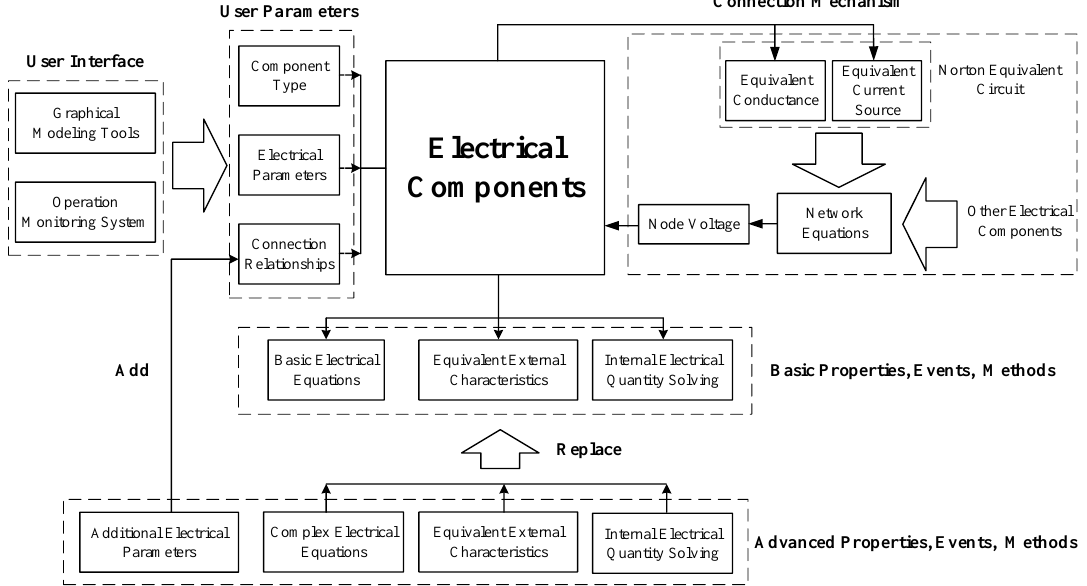
Figure 9. Schematic diagram of component reconstruction.